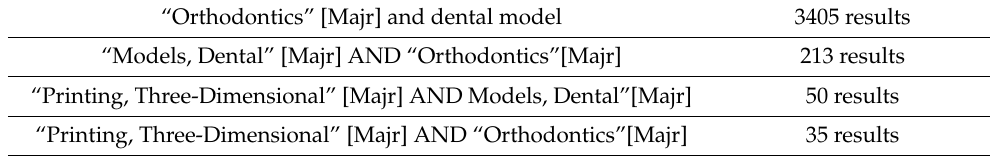
Table 1. The search strategy for PubMed.